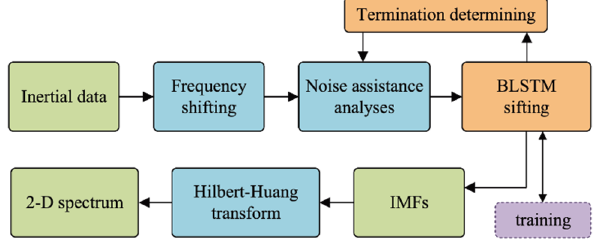
Figure 2. Proposed BLSTM-based HHT structure.